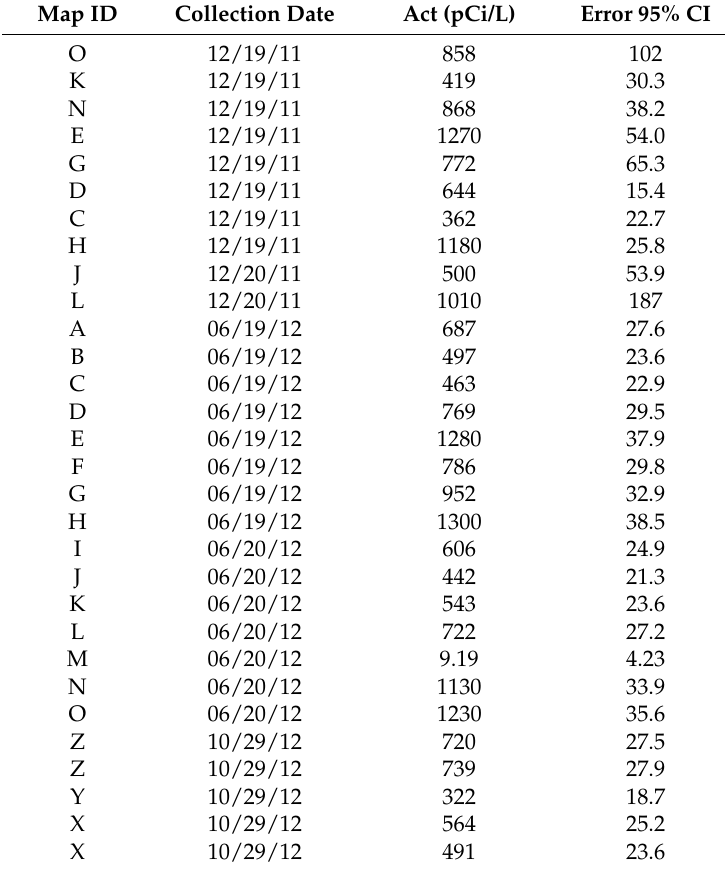
Table A1. Measured 222 Rn activity levels for wells and springs in the Martis Valley region corresponding to locations on Figures A1 and